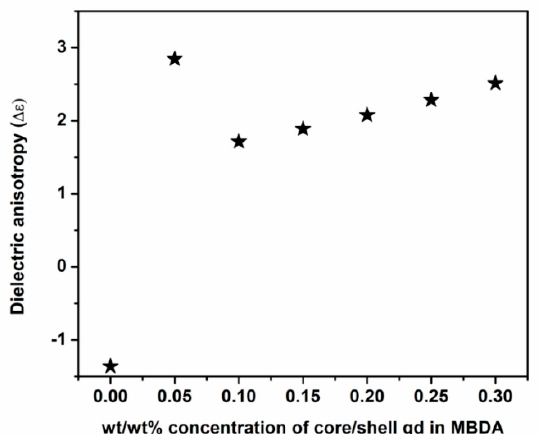
Figure 7. Dielectric anisotropy of pure nematic MBDA and its mixture with core/shell quantum dots (Mix 1 to Mix 6) at a 1 kHz frequency.